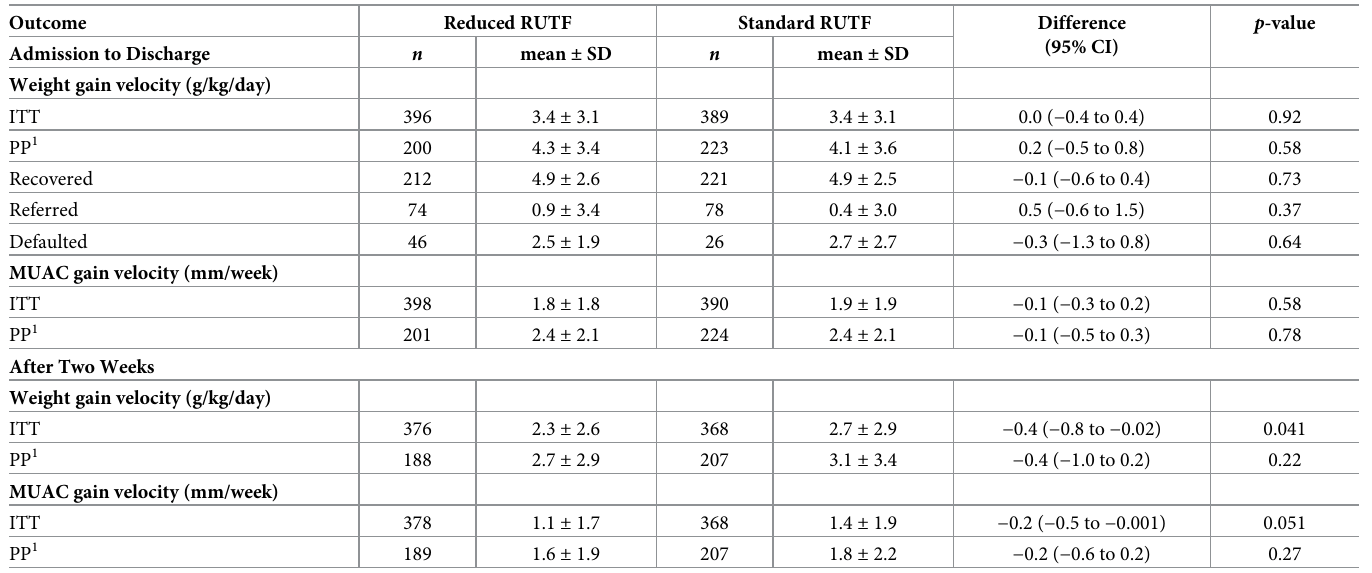
Table 3. Weight and MUAC gain velocity of children with SAM randomised to reduced or standard RUTF dose in unadjusted model.